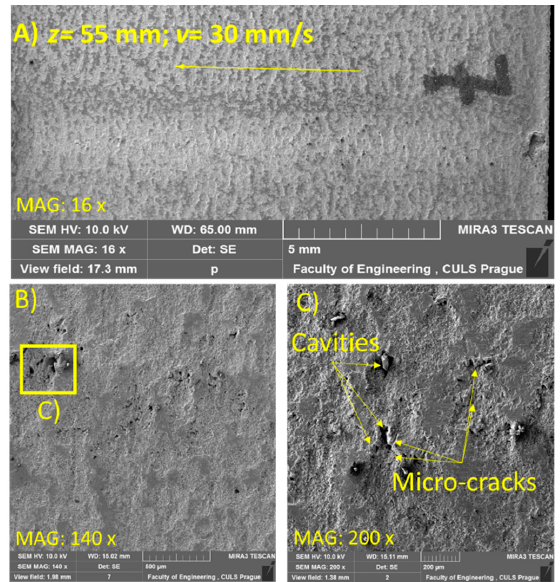
Figure 7. SEM image of sample subjected to p = 70 MPa, z = 55 mm, and v = 30 mm/s (A) at magnification 16×, (B) At magnification 140× and (C) At magnification 200×.